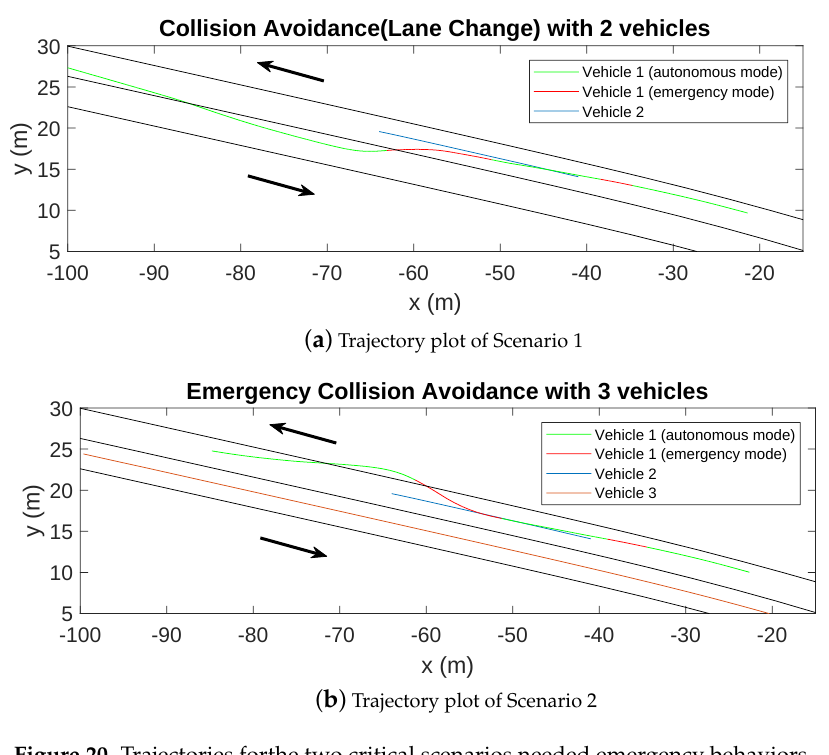
Figure 20. Trajectories forthe two critical scenarios needed emergency behaviors.